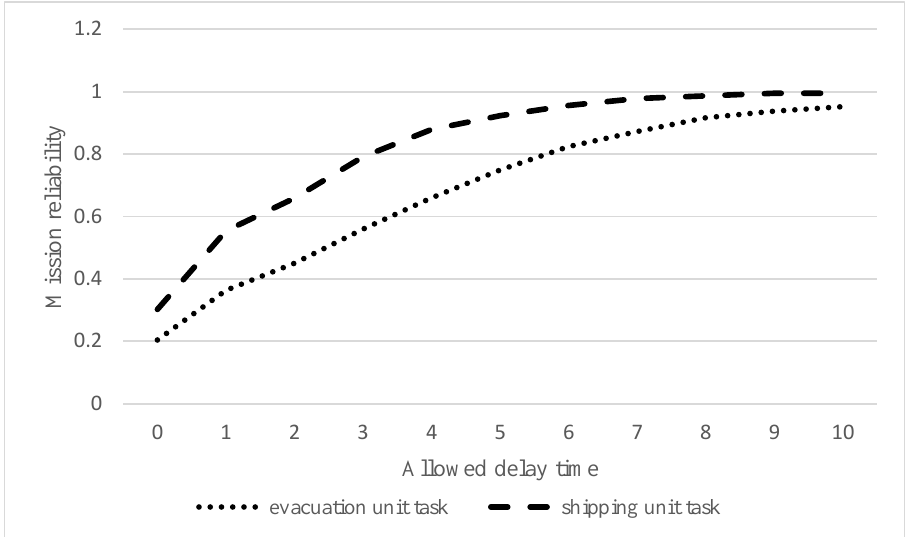
Figure 18. Mission reliability of shipping unit task and evacuation unit task.